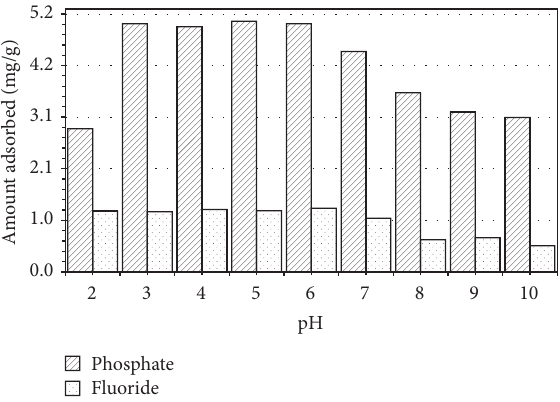
Figure 3: Effect of pH on adsorption of fluoride and phosphate on LDPO-G (initial concentrations of phosphate: 30 mg/L and fluoride: 10mg/L; contact time: 2 hrs).